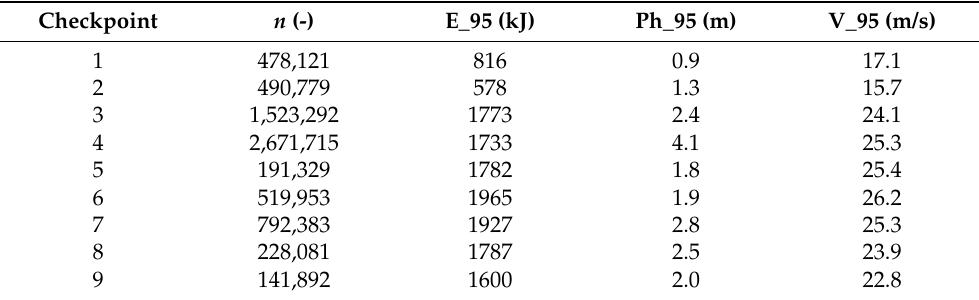
Table 2. Summary of Rockyfor3D simulations outputs in the FPRE scenario. For each checkpoint, the table reports: n , the total number of registered passages of falling rocks; E_95, the 95th percentile of the energy of registered falling rocks; Ph_95, the 95th percentile of passing height values recorded at the checkpoint; V_95, the 95th percentile of the speed of registered falling rocks.